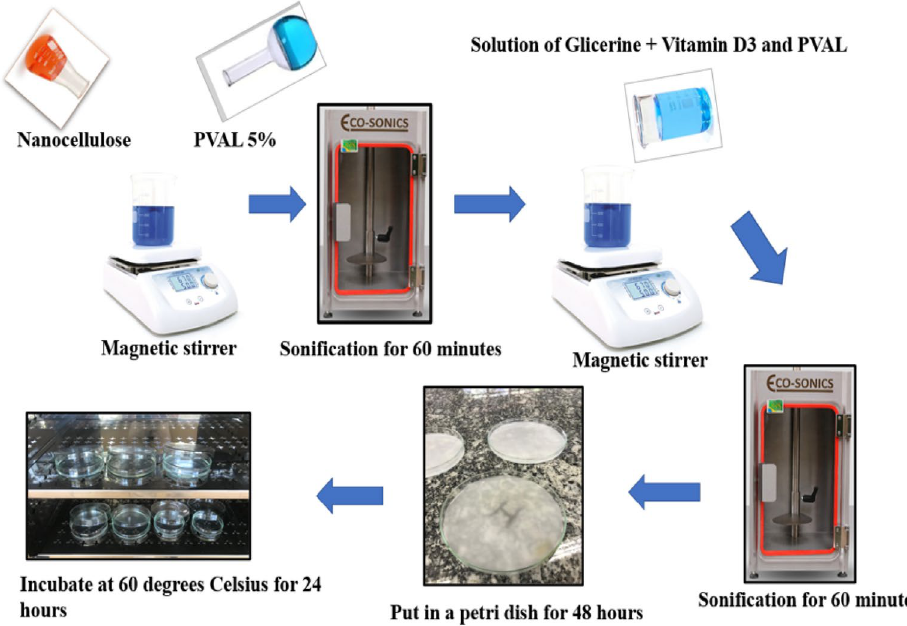
Figure 1. Illustration of the procedure used to produce the nanocellulose membranes containing vitamin D 3